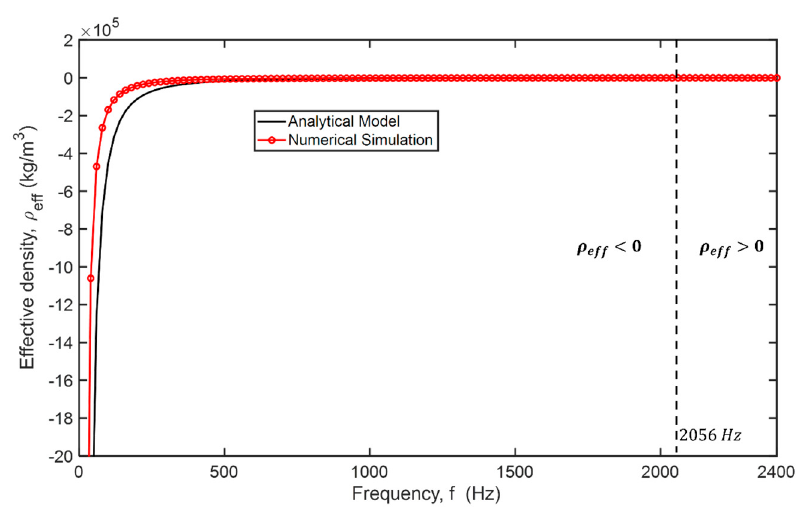
Figure 2. The clamped hexagon plate ′ s dynamic mass density is calculated by the analytical model (solid black line) and the numerical simulation (solid red line with marker). The fundamental resonance of the thin plate is at 2056 Hz.